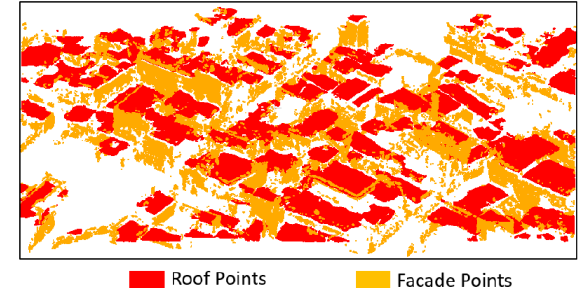
Figure 7: Segmented roof and facade